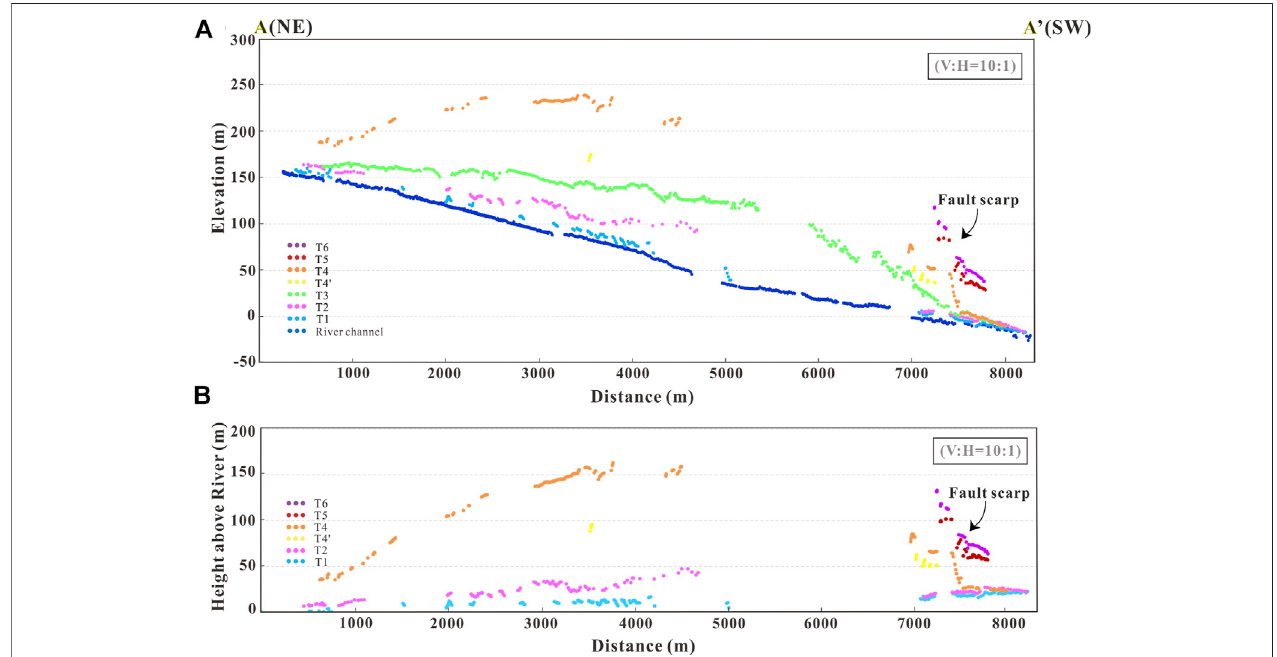
FIGURE 5 | (A) Terraces and river channel longitudinal pro fi les across the Huoyanshan structure showing the pattern and amounts of deformation of different terraces. (B) Relative heightsoftheterraces tothemodernriverchannel;apolynomialthat fi tsthemodernriverbed issubtracted fromeach fl uvialterrace toeliminatethe modern river gradient. The vertical exaggeration is 10. The distance is projected along line A-A ’ , where A ’ is the direction downstream, and a fault scarp exists at the southern margin of the Tuyugou valley (see Figure 3C for the location).